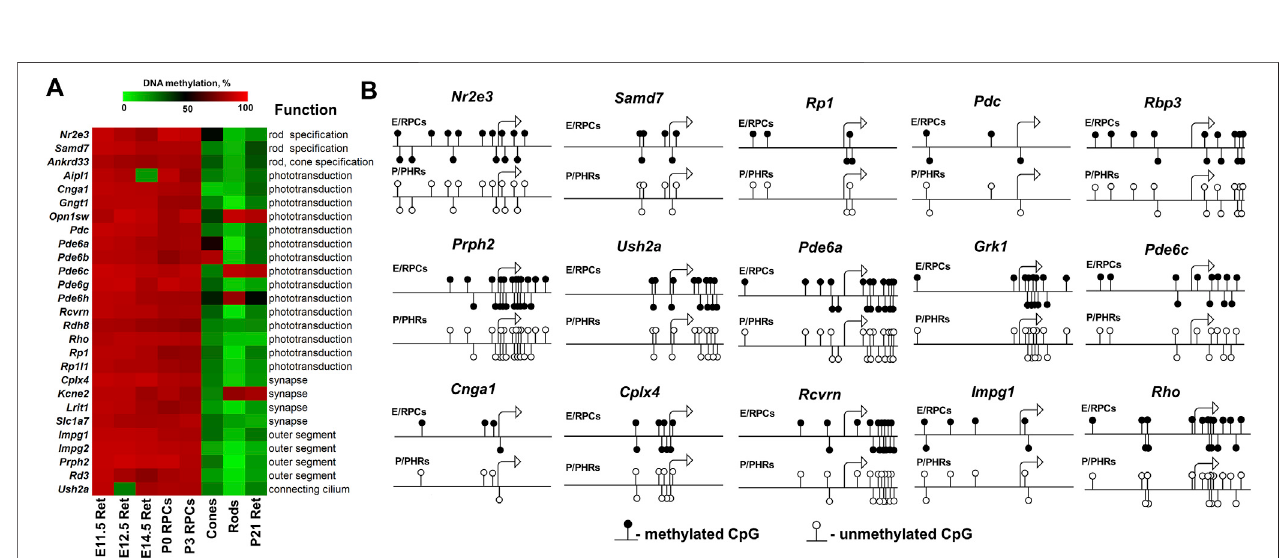
FIGURE 5 | Many promoters of genes required for photoreceptor inner and outer segment function are hypermethylated in human (A) and mouse (B) embryonic retinas/RPCs.